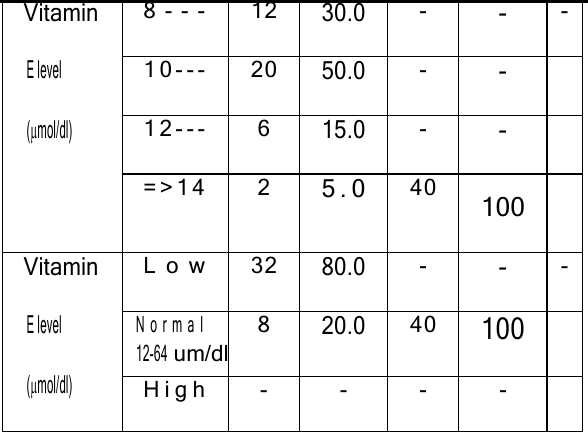
*Significant difference between proportions using Pearson Chi-square test at 0.05.